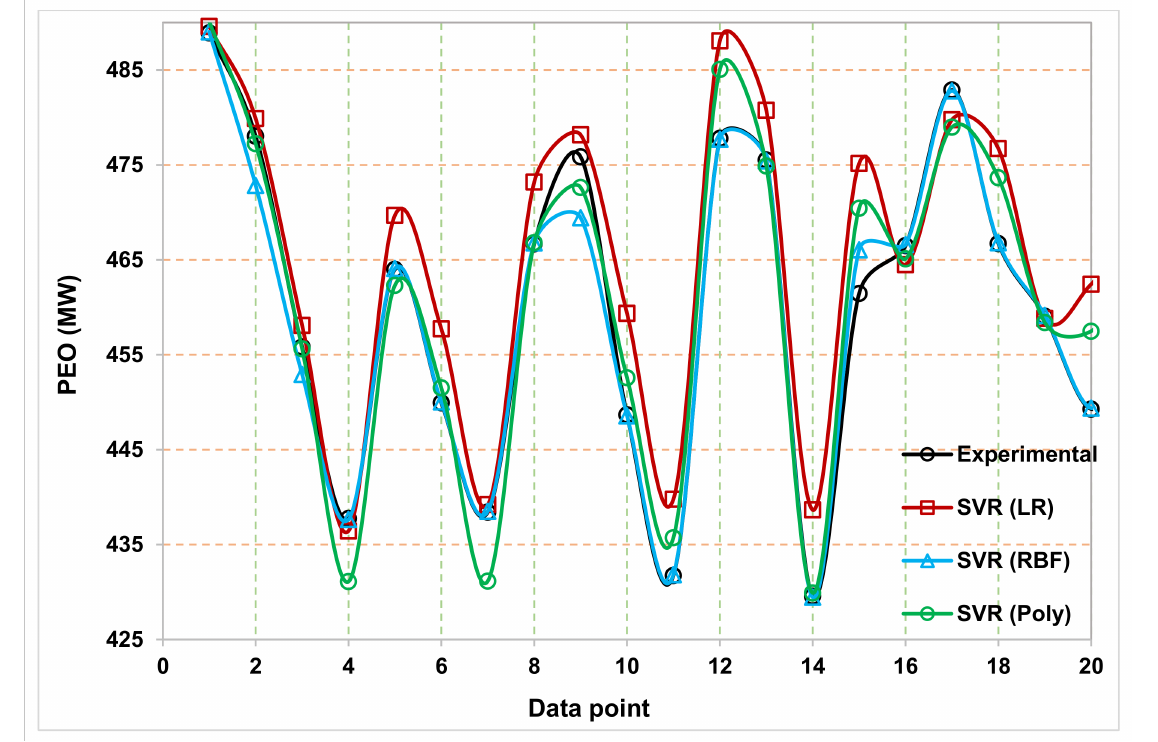
Figure 15. Comparison between the actual readings of CCPP energy output (PEO) and trained values produced from computations of SVR (LR), SVR (RBF), and SVR (Poly.) algorithms during the training indicating first 20 data points only.